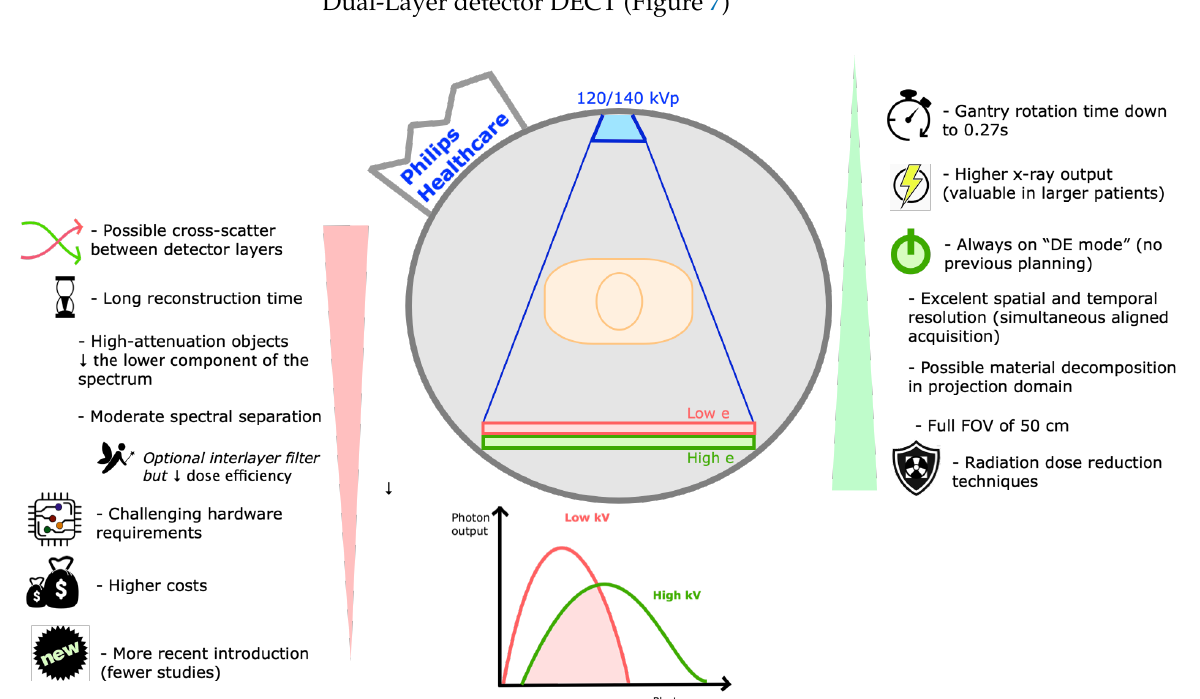
Figure 7. Dual-layer detector DECT. Schematic representation of a dual-layer detector DECT scanner and its drawbacks (listed on the left) and strengths (listed on the right). These scanners (commercialized by Philips Healthcare) are composed of a single source (fixed energy of 120 or 140 kVp) and a single detector with 2 layers (lower-energy photons preferably absorbed by the top layer and the bottom layer absorbs the remaining higher-energy photons). DE—dual-energy, e—energy, FOV—field of view, kVp—peak kilovoltage, s—seconds.